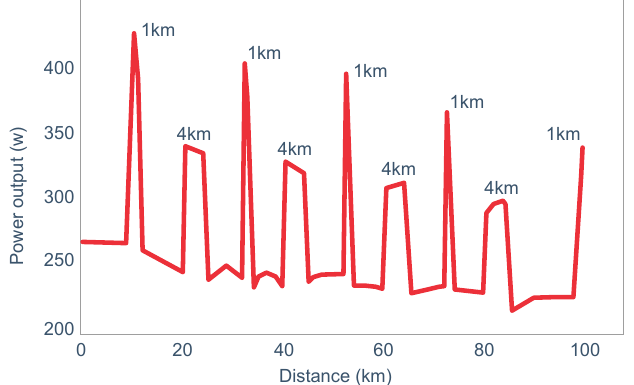
Figure 17. Power outputs measured in a series of 1 and 4 km sprints during a 100 km cycling time trial in the laboratory, fell progressively. This reduction could be due either to mechanisms present in the exercising muscles (peripheral fatigue) or the result of reduced motor unit recruitment in the exercising muscles by the motor cortex in the brain (central regulation).